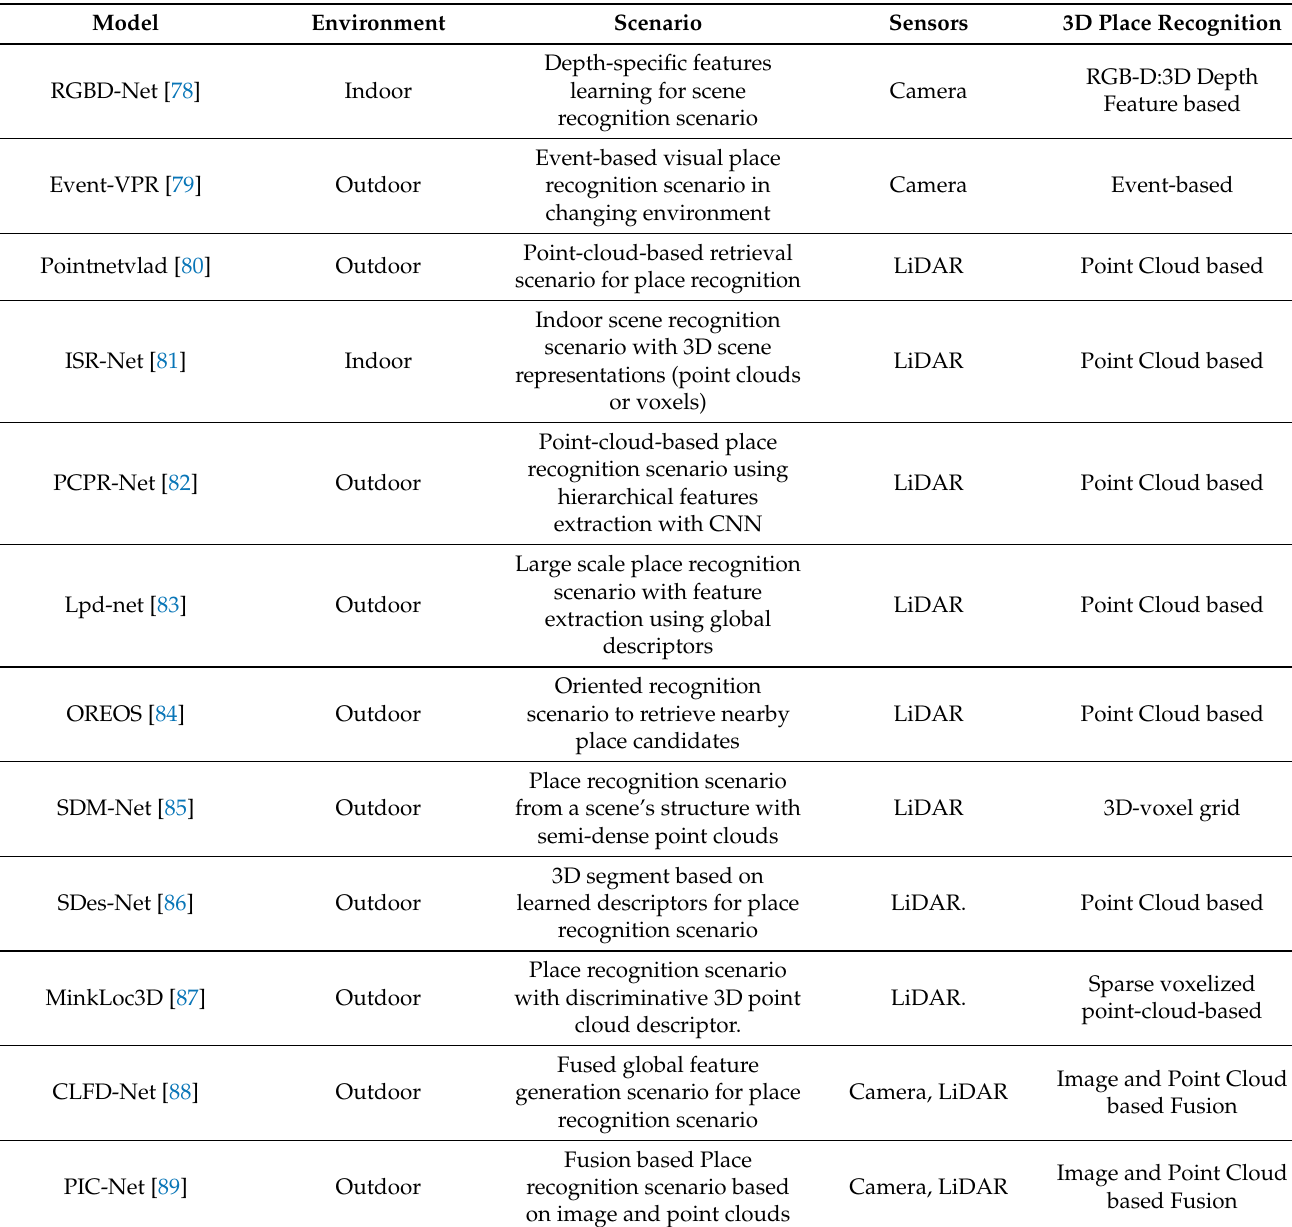
Table 19. Literature Analysis: 3D Place Recognition (3DPR)